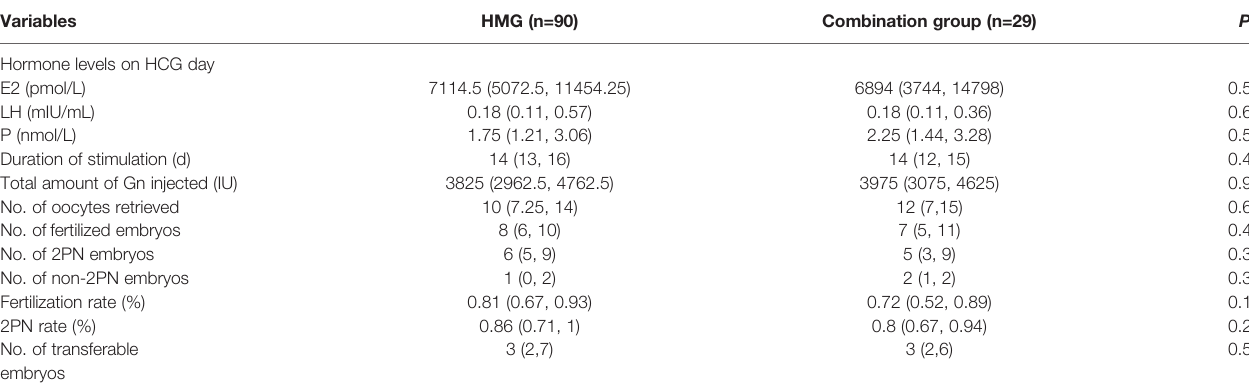
TABLE 3 | Comparison of IVF related parameters between HMG and combined medication group.